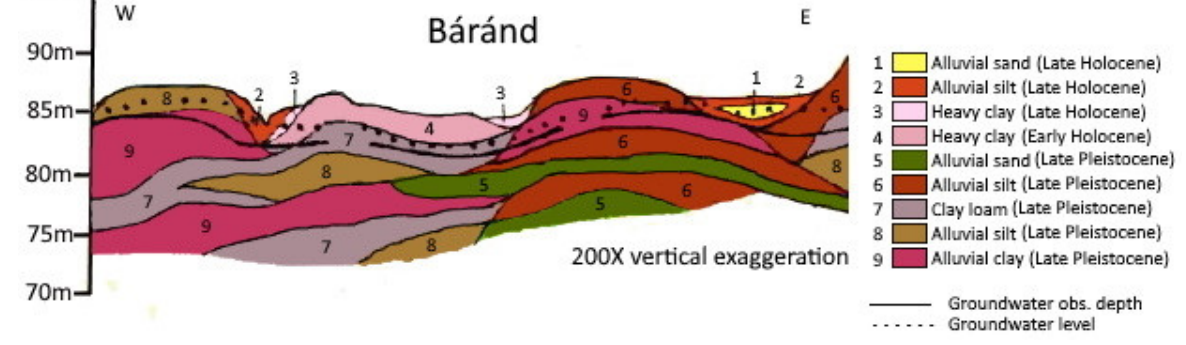
Figure 1. Geological cross section of the study area (Modified based on Rónai 1980 [46]).